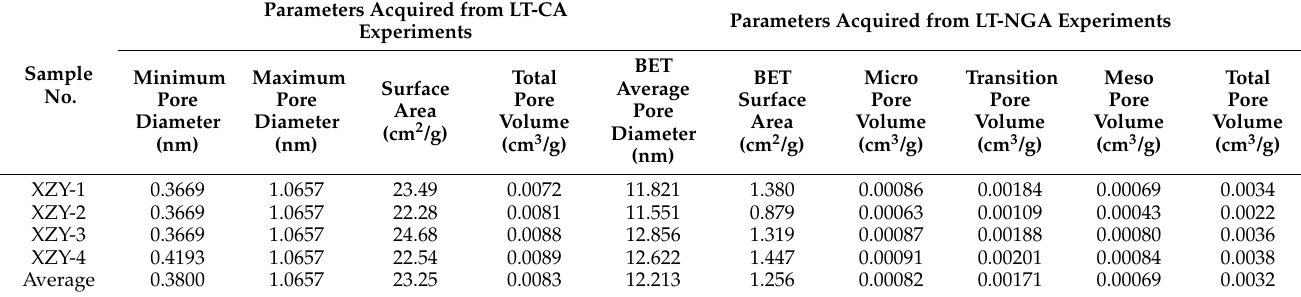
Table 1. Gas adsorption experimental results.